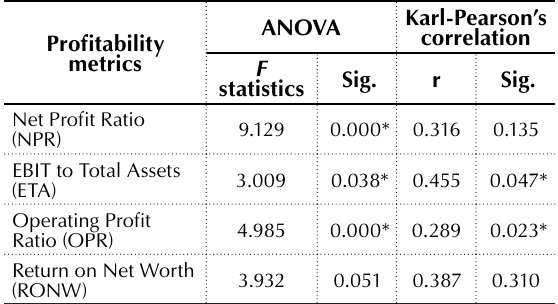
Table 3. Results of ANOVA and Correlation Analysis of the relationship between measures of profitability and dividend pay-out ratio